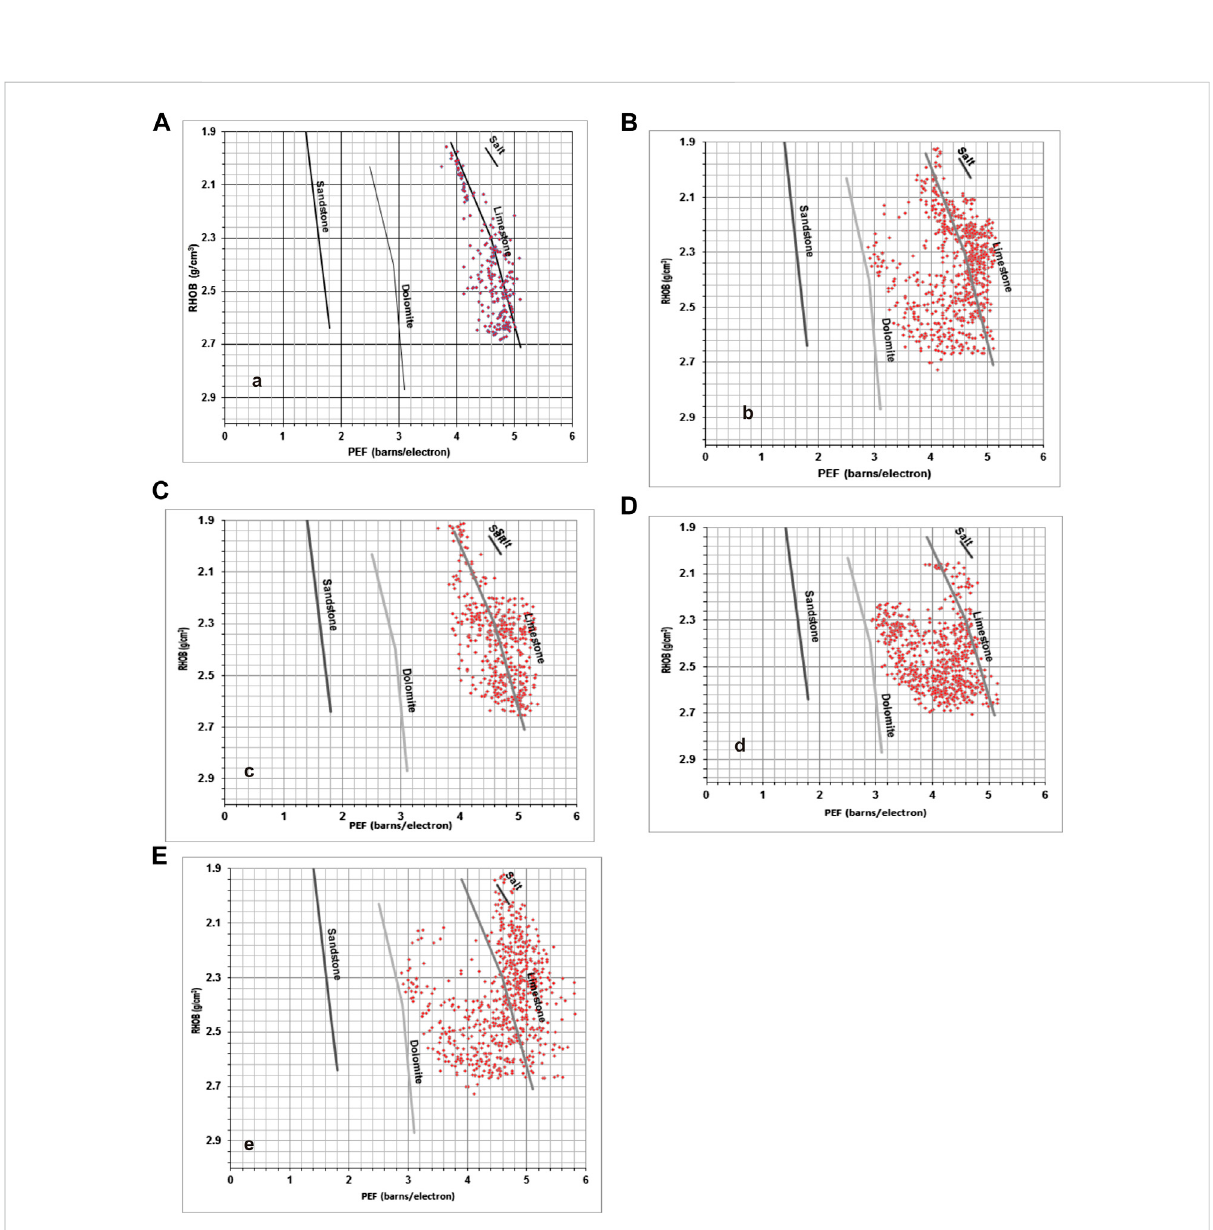
FIGURE 6 Cross plots between photoelectric absorption factor PeFlog and bulk density log indicate major lithologyin theSui Main Limestone (A) for well Q-01, (B) well Q-03, (C) well Q-05, (D) well-Q-12, (E) well-Q-15.